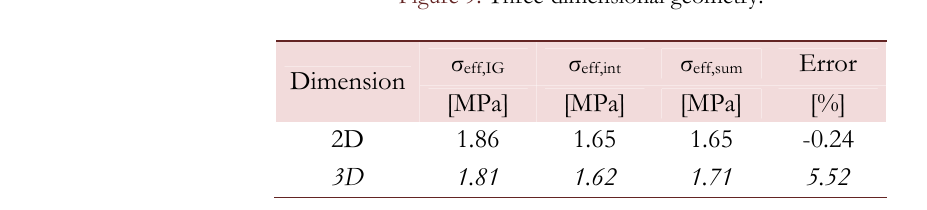
Table 5: Comparison between 2D-3D of the same